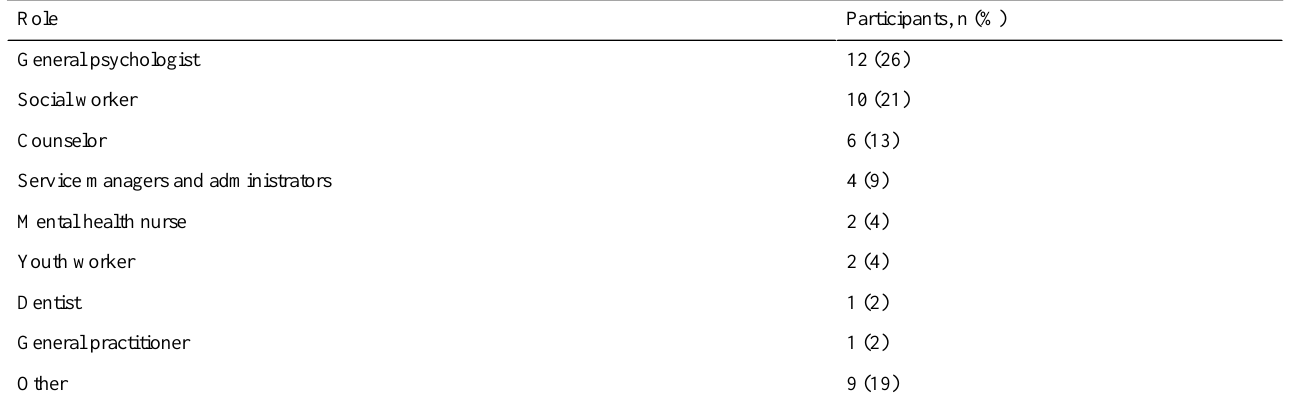
Table 1. Participants’(n=47) roles across services.